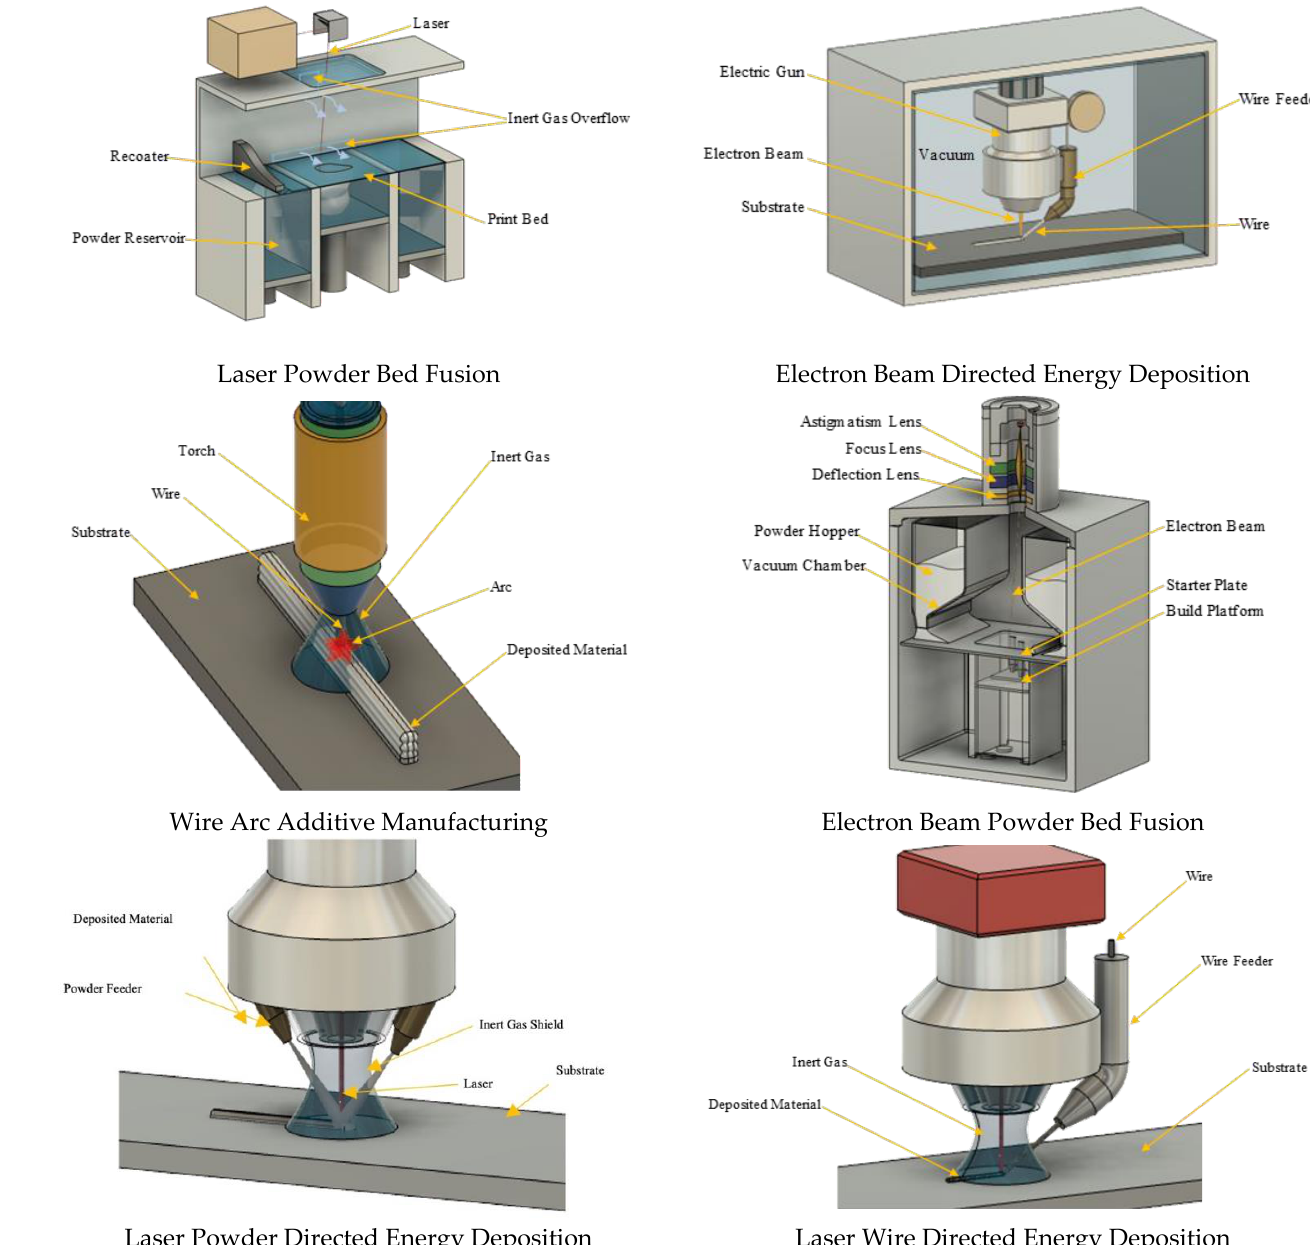
Figure 1. AM process schematic visualizations for layer-building techniques used in this research. Multiple specimens representing the six AM processes (L-PBF, WAAM, EB-DED, LP- DED, EB-PBF, and LW-DED) investigated in this study were evaluated and tested. The parameters used to build each sample are provided in Table 1. In Table 2, an index of each sample is provided, along with a description of the geometries of the as-built specimens. For the LP-DED and LW-DED, different specimens were created to observe any change in microstructure or mechanical property between the varying parameters. The LP-DED had the same build toolpath approach but varied the spot size and subsequent power (from 350 W to 2620 W) and powder feed rate for this study. The coupons ’ build varied based on parameters; small coupons were printed with the finest parameters, while faster parameters deposited blocks in order to be more representative of builds using those pa- rameters. The LW-DED samples had a variation only in the tool path used in the build.